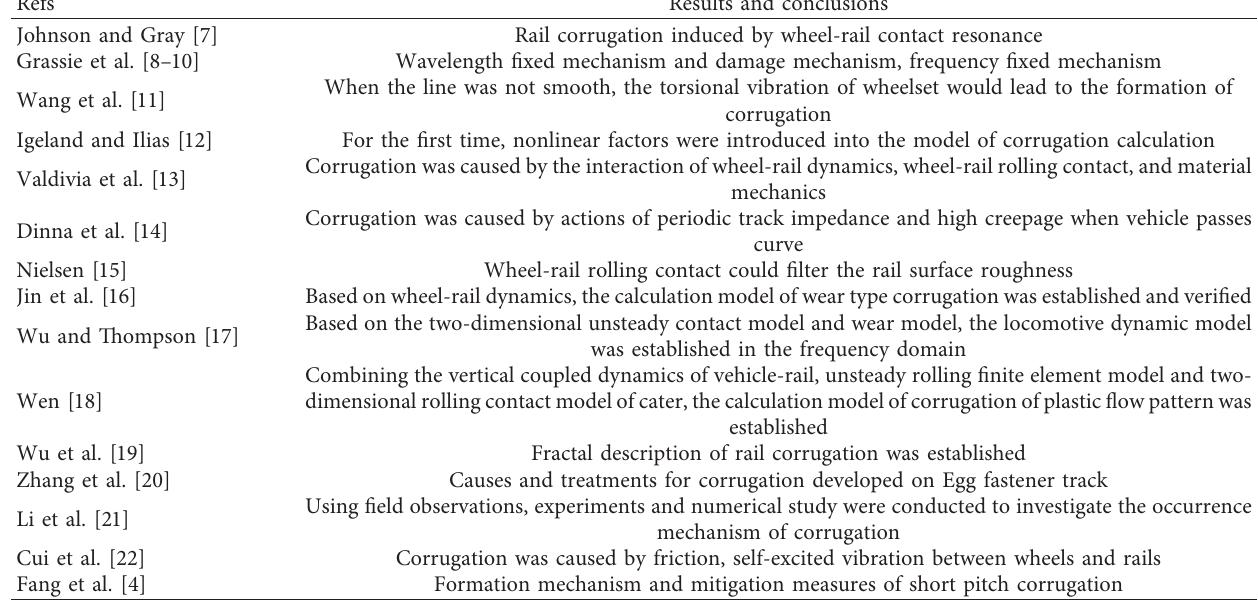
Table 1: History of corrugation